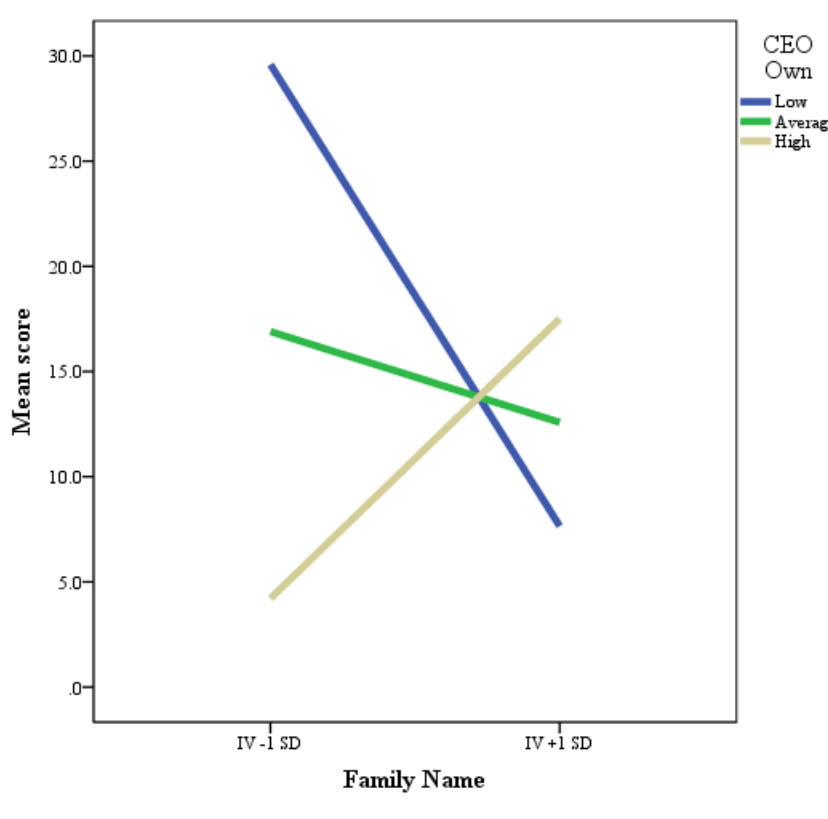
Figure 2. Interaction Plot: Family Name and CEO Own.